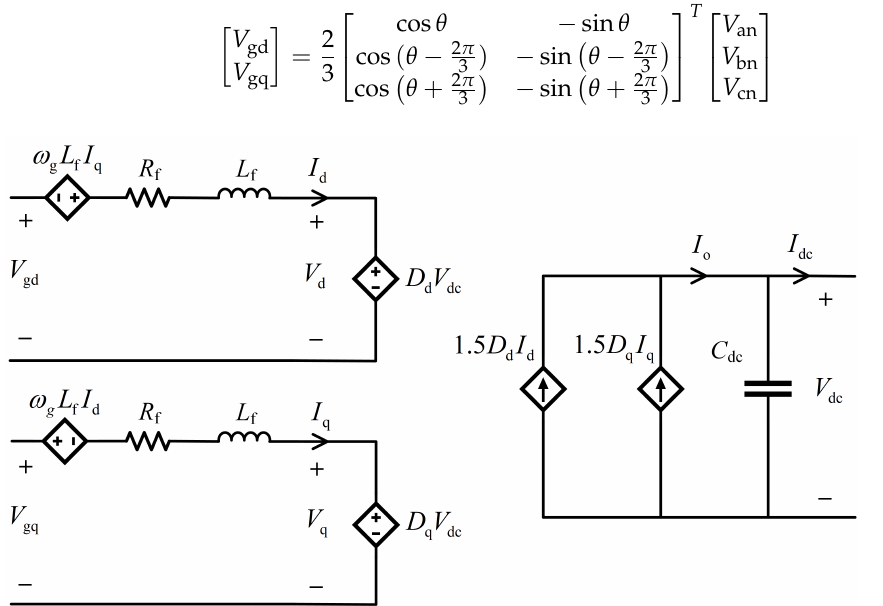
Figure 2. The open-loop model of the